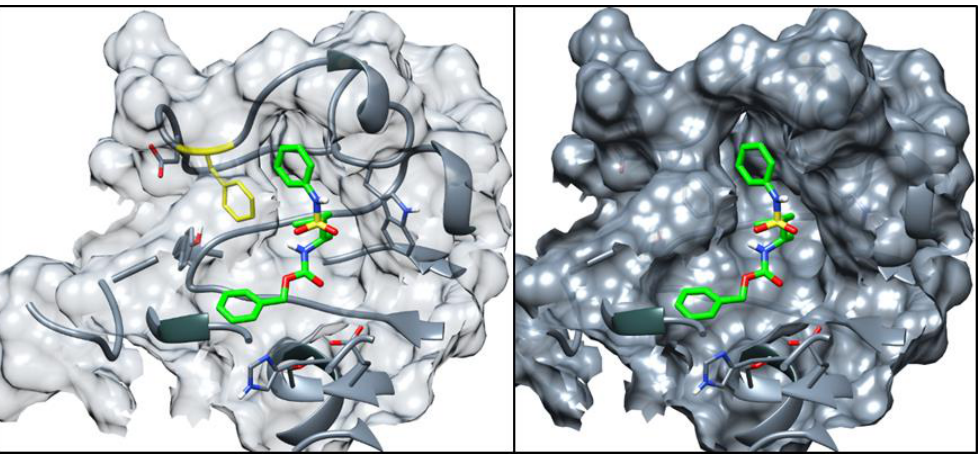
Figure 7. Two different representations of the active site of Torpedo californica AChE when complexed with compound 5d (green). The gorge of the enzyme is depicted by its molecular surface in (semi-transparent) gray. The Phe75 residue is depicted in yellow. The amino acid residues from the catalytic triad are also shown.